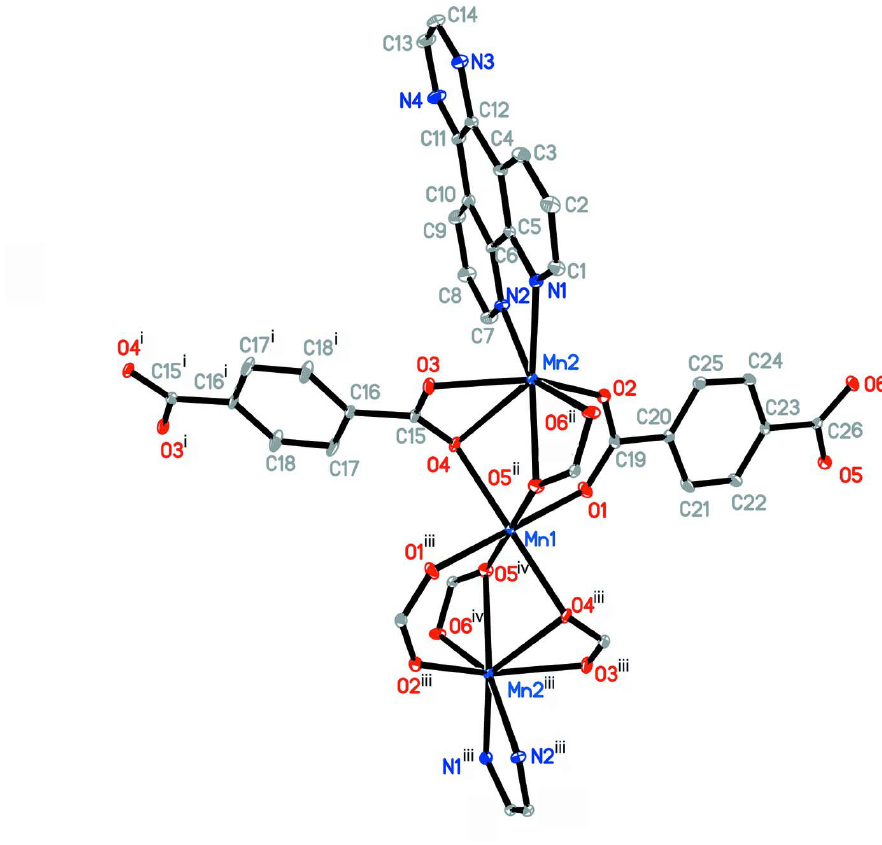
The structure of (I), showing the atomic numbering scheme. Displacement ellipsoids are drawn at the 20% probability level. H atoms and also some C atoms have been omitted for the sake of clarity. Symmetry code: (i) 1- x , 2- y , 1- z ; (ii) x , 0.5- y , z -0.5; (iii) 1- x , 1- y , 1- z ; (iv) 1- x , 0.5+ y , 1.5- z